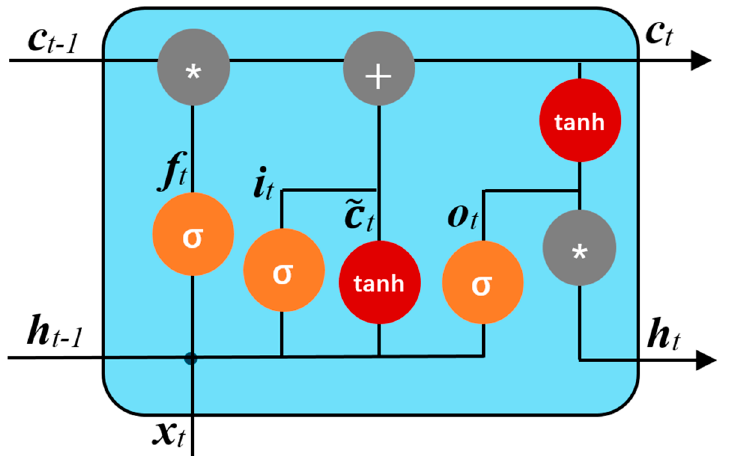
Figure 9. LSTM internal unit structure.